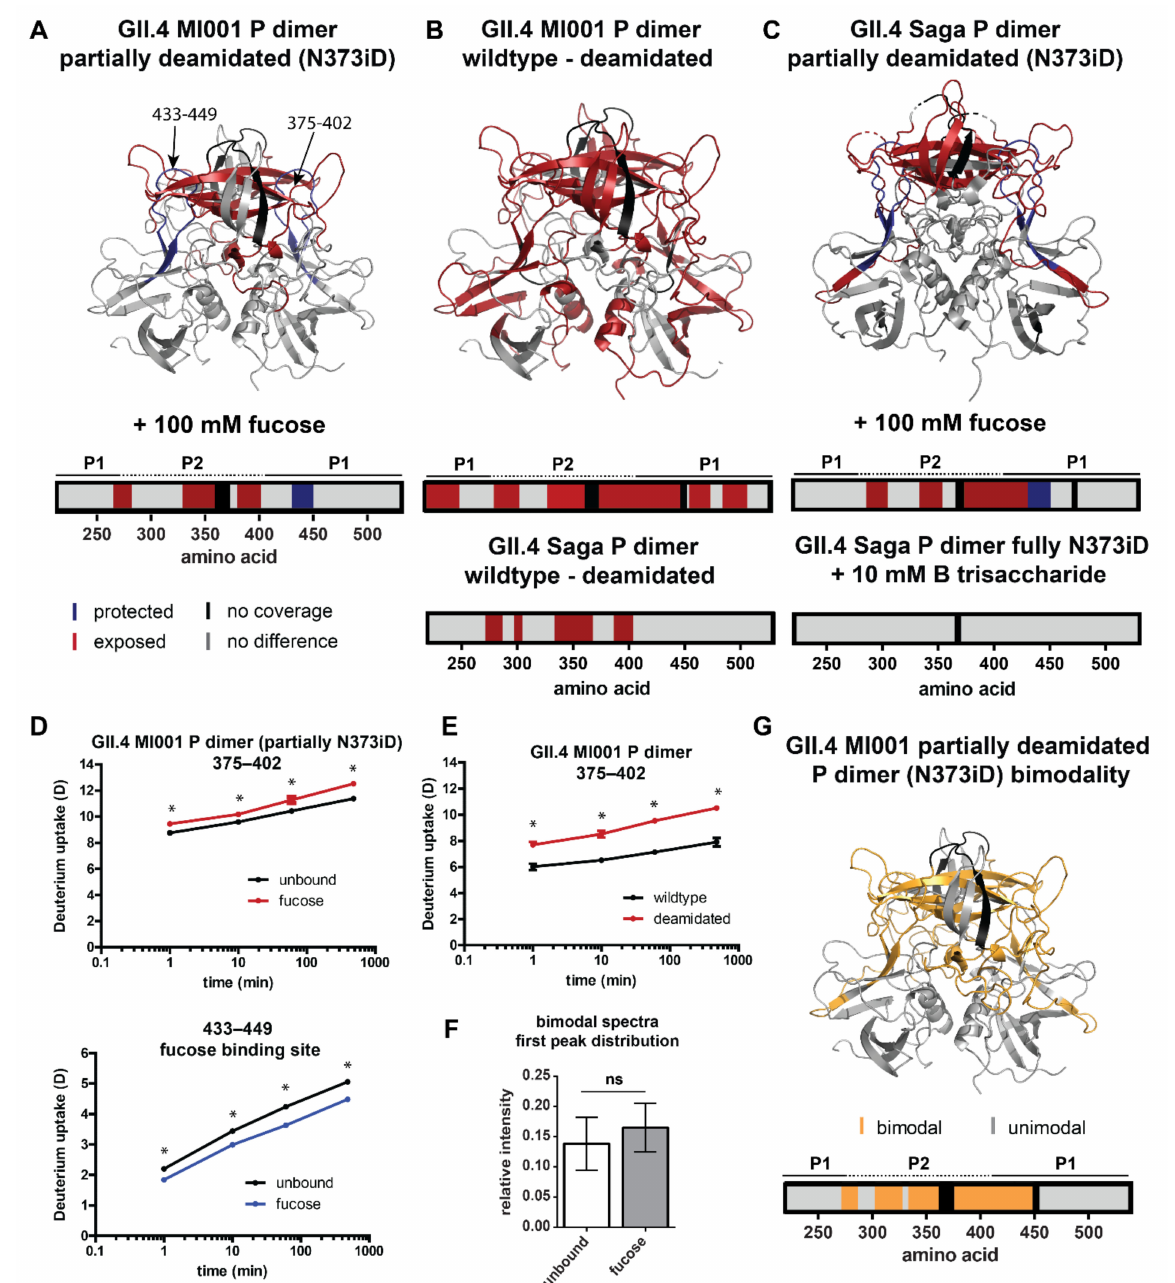
Figure 4. Significant HDX differences in partially deamidated (N373iD) GII.4 P dimers. A/C/D) Fucose can still bind to the canonical glycan binding site in partially deamidated GII.4 MI001 ( A ) and GII.4 Saga ( C ) P dimers (pdb 6H9V). In contrast to the wildtype N373 P dimer, parts of the P2 domain get more exposed upon interaction with 100 mM fucose. HDX differences in fully deamidated GII.4 Saga P dimers in presence of 10 mM HBGA B trisaccharide are shown for comparison [15]. ( B , E ) The partially deamidated GII.4 MI001 N373iD P dimer shows a higher deuterium uptake in large parts of the structure, which points towards higher flexibility, like in the fully deamidated GII.4 Saga P dimer shown for comparison [15]. ( D , E ) Deuterium uptake plots exemplarily highlight statistically significant (*) deuteration differences in partially deamidated GII.4 MI001 P dimers in presence of fucose ( D ) and in comparison to the wildtype protein ( E ). All uptake plots show deuteration values of the second (main) peak distribution in case of bimodality. ( F , G ) Bimodality occurs in similar regions as for the wildtype P dimer, implying that the more protected subpopulation is also present in the